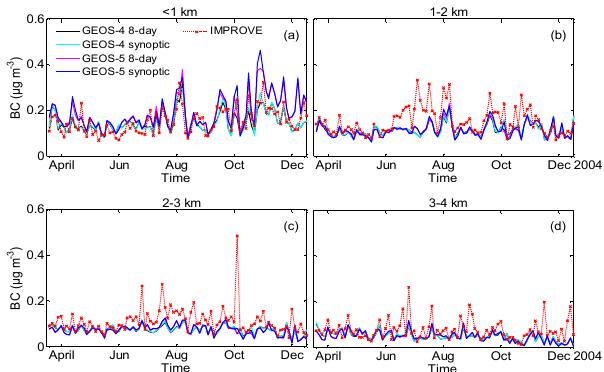
Figure 11. (a-d) Same as Figure 4, but for April-December 2004 and with 8-day Fig. 11. (a–d) Same as Fig. 4, but for April–December 2004 and GFEDv2 emissions (black line, GEOS-4; pink line, GEOS-5) and synoptic GFEDv2 with GFEDv2 8-day emissions (black line, GEOS-4; pink line, emissions (green line, GEOS-4; blue line, GEOS-5). GEOS-5) and GFEDv2 synoptic emissions (green line, GEOS-4; blue line, GEOS-5).